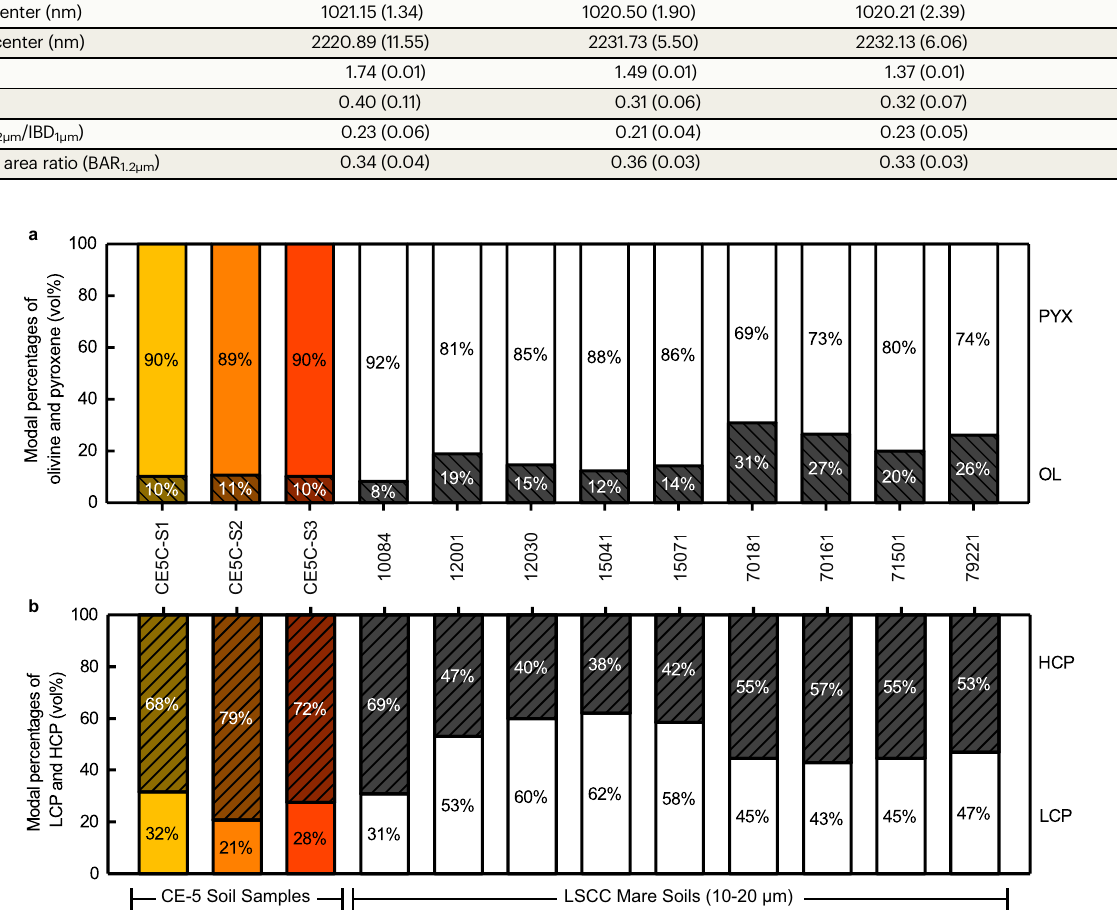
100%,respectively.Giventhat10 – 20 μ msizefractioncouldberepresentativeof bulk soil properties 42,43,45 , only 10 – 20 μ m LSCC soil data are used to compare with CE-5 soil samples. The fi ve-digit number (e.g., 10084) corresponds to the Apollo sample